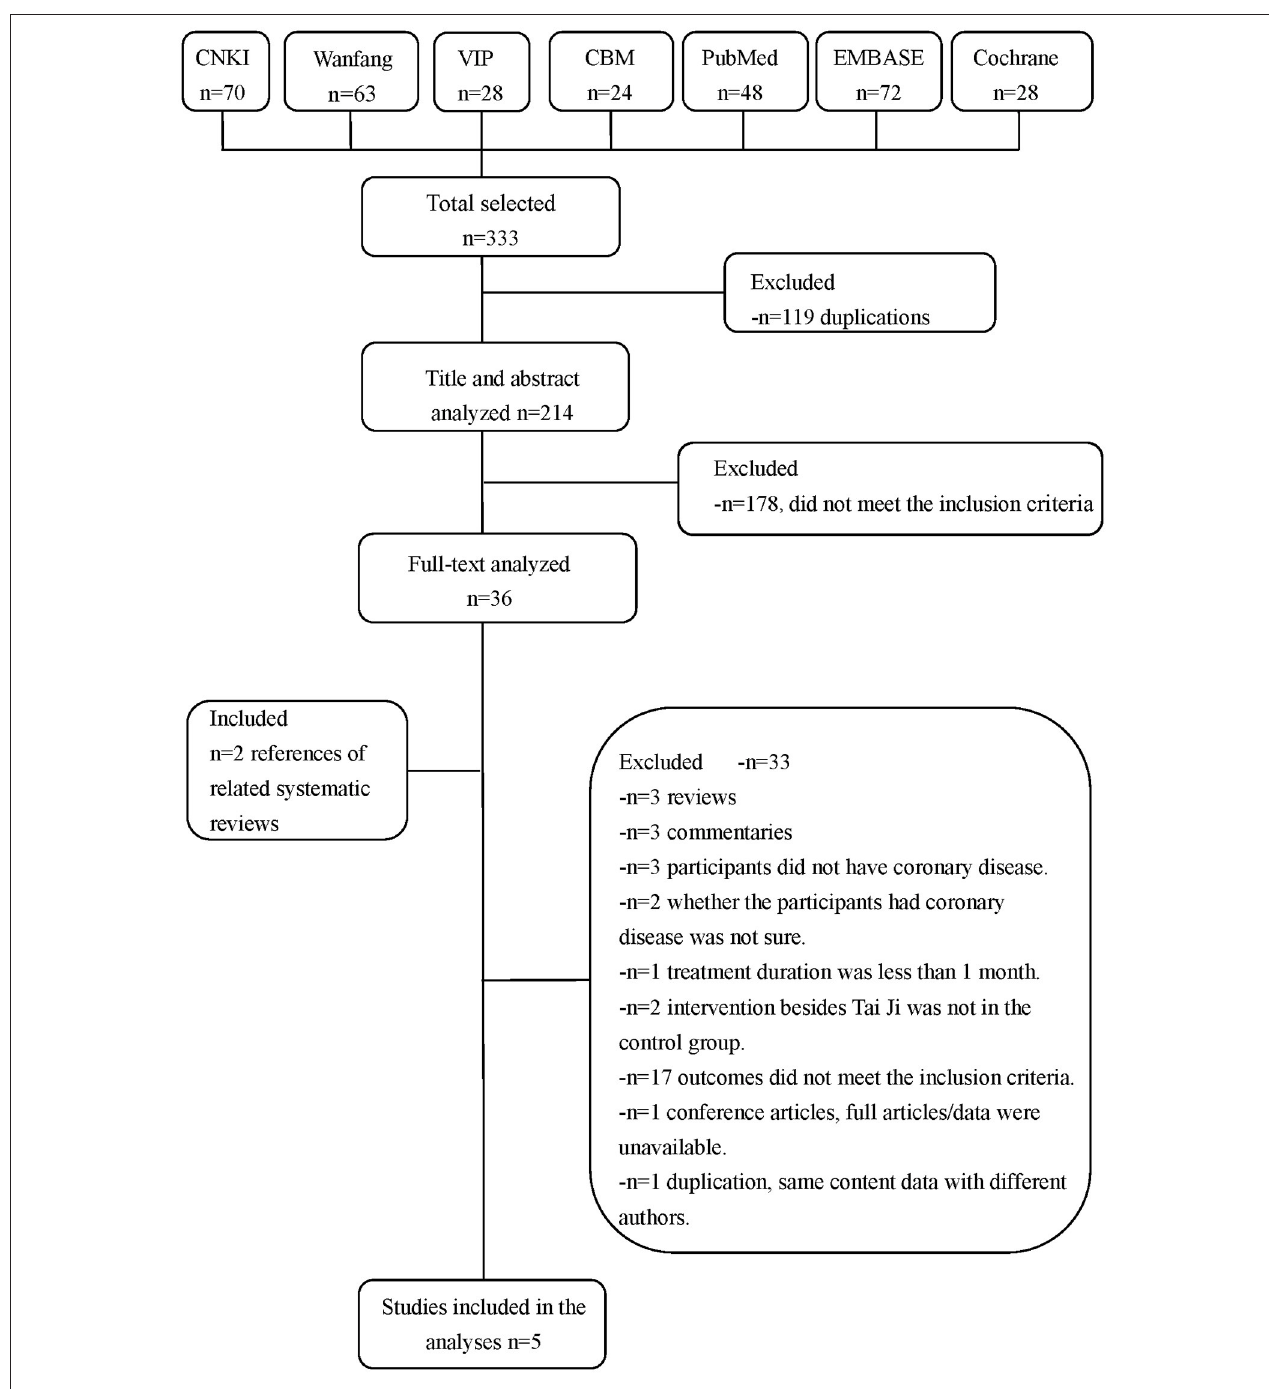
FIGURE 1 | Literature screening